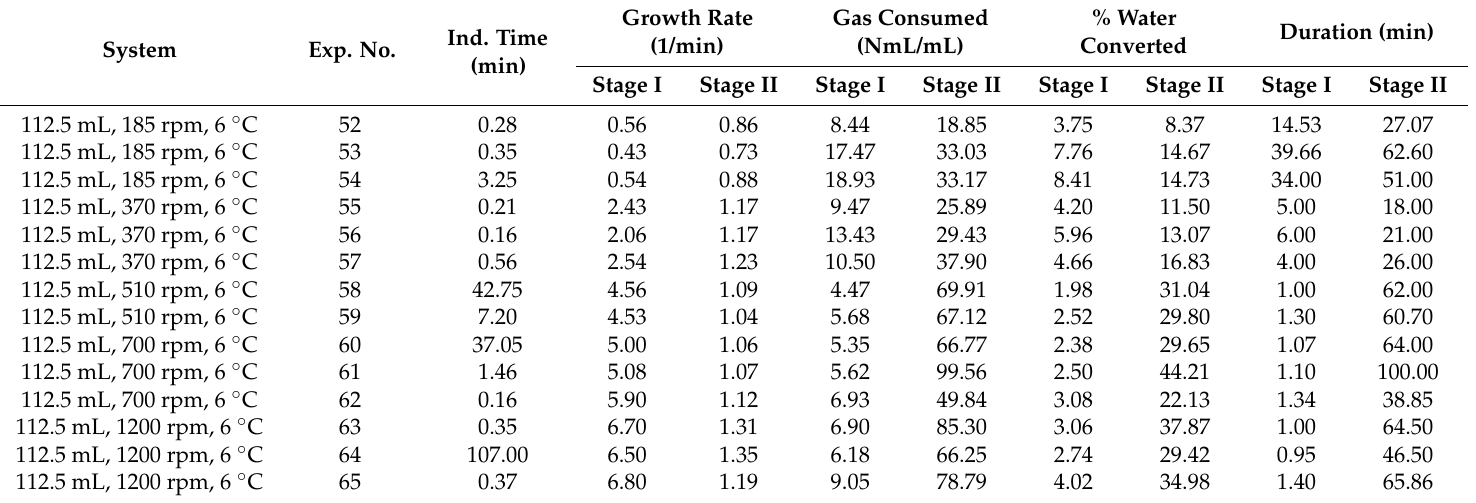
Table 6. Summary of results including total gas consumption and percentage water converted to hydrate at the end of growth stage II, and induction time measurements for each experiment (318.1 mL